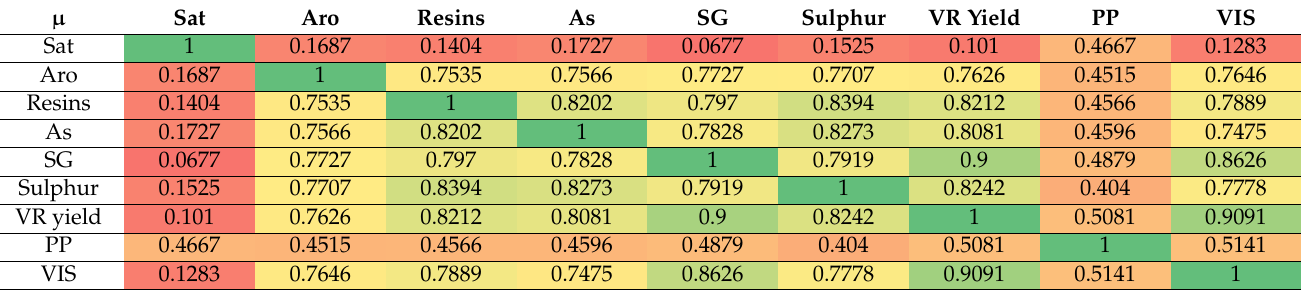
Table 5. µ -value of the ICrA evaluation of relations between crude oil SARA composition data and bulk properties.